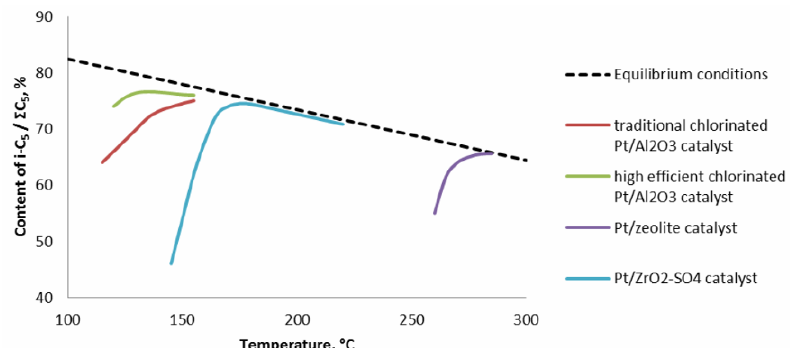
Figure 5. TAEE formation [19].